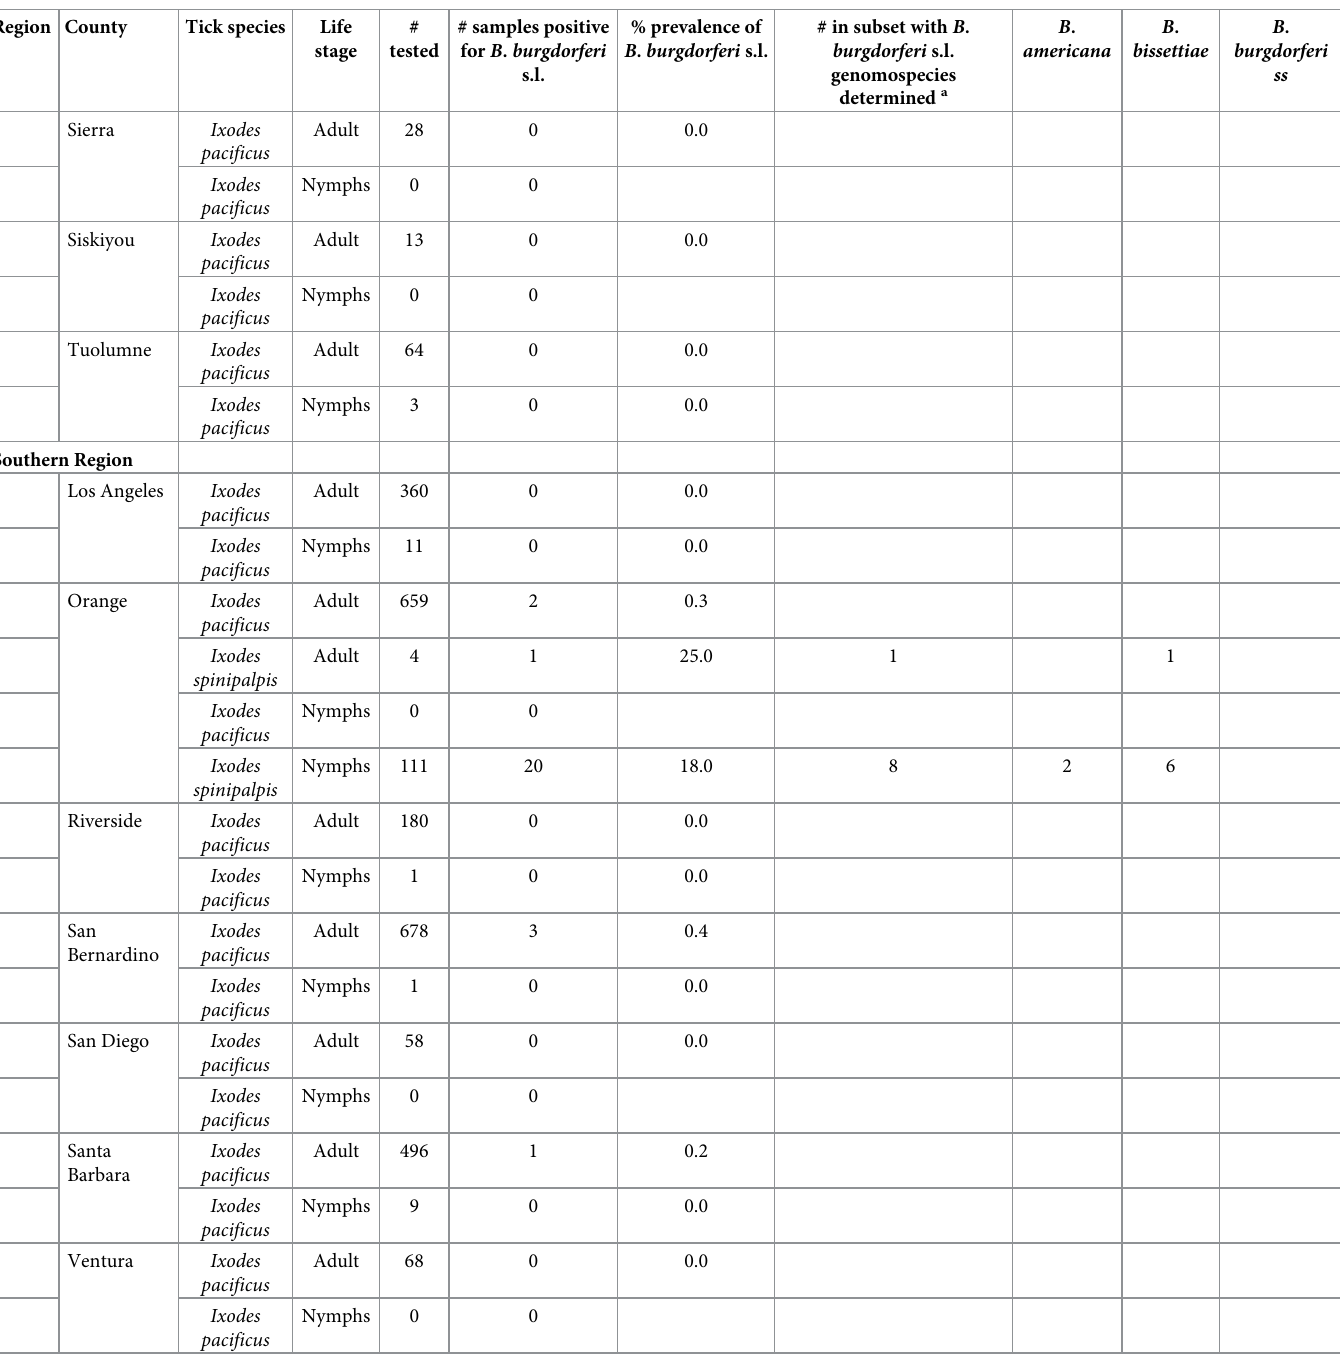
disease to people, this risk is not uniform throughout the region. For example, despite thou- sands of ticks tested to date, the only ticks found positive for B . burgdorferi ss from southern California are one adult I . pacificus and two Dermacentor occidentalis from Los